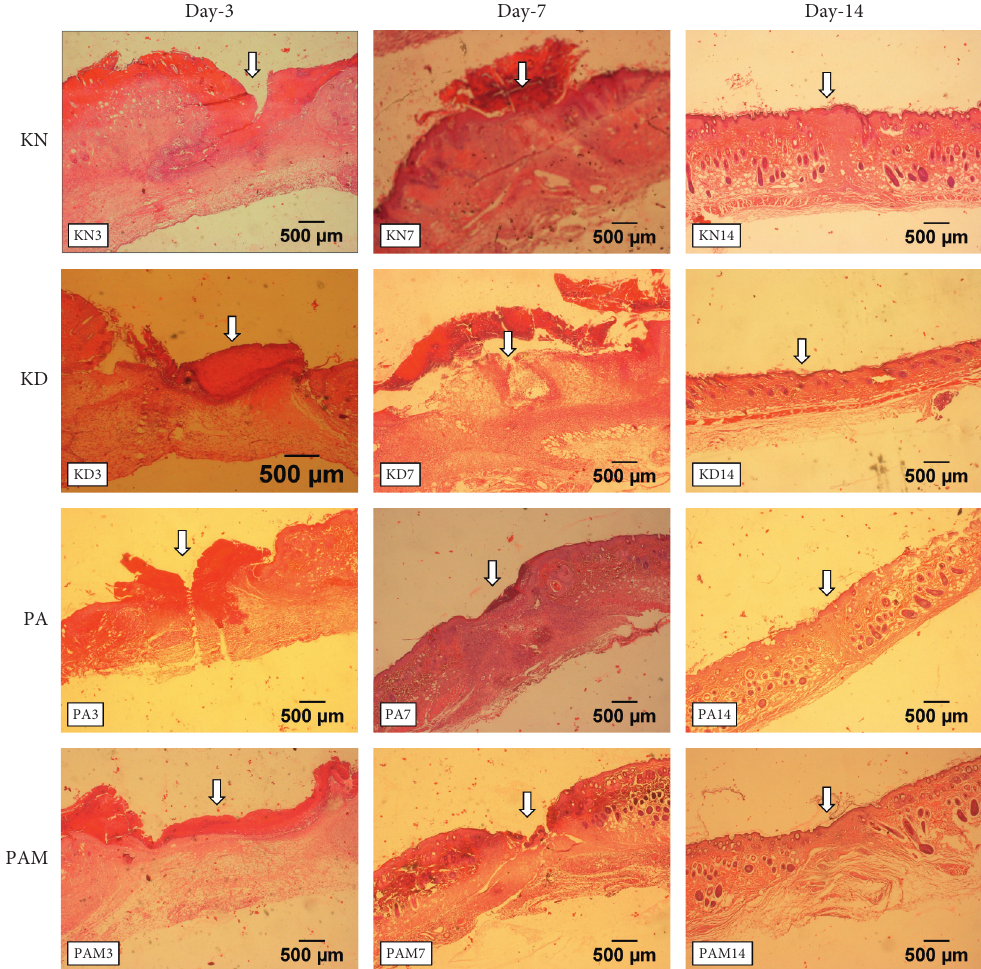
Figure 2: Histology of the wound healing site (pointed by white arrows). KN: normal control, KD: diabetic control, PA: S. duplicatum extract treatment, and PAM: the combination of S. duplicatum and G. mangostana extract